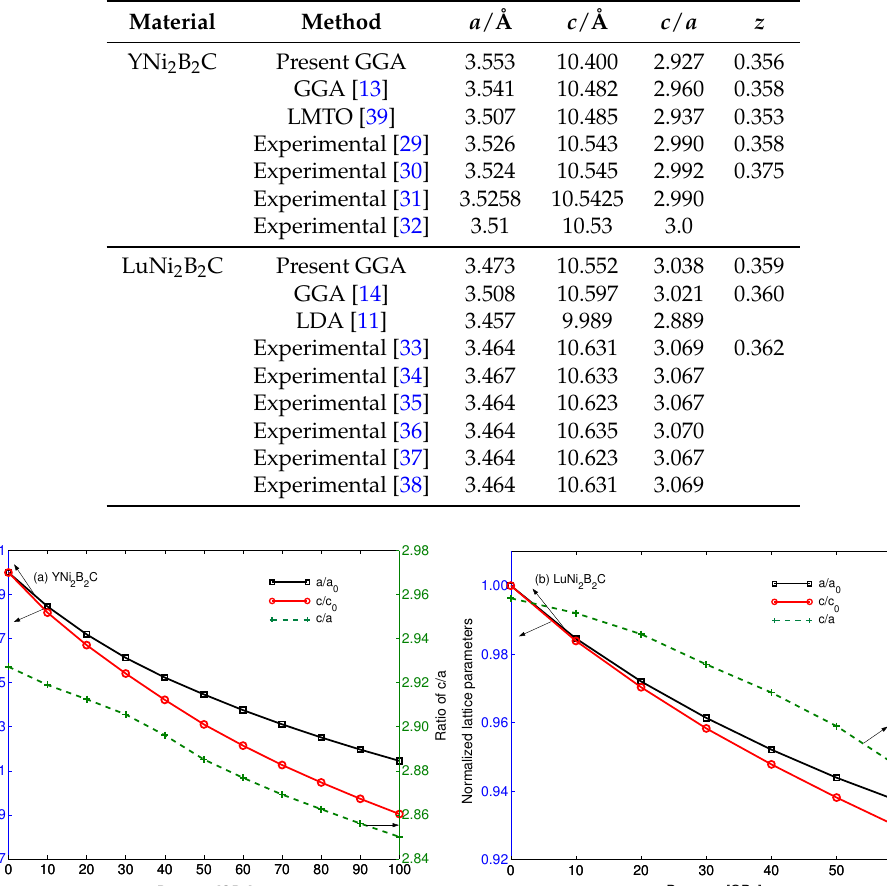
Figure 3. Normalized parameters a / a 0 , c / c 0 , c / a of ( a ) YNi 2 B 2 C and ( b ) LuNi 2 B 2 C as a function of